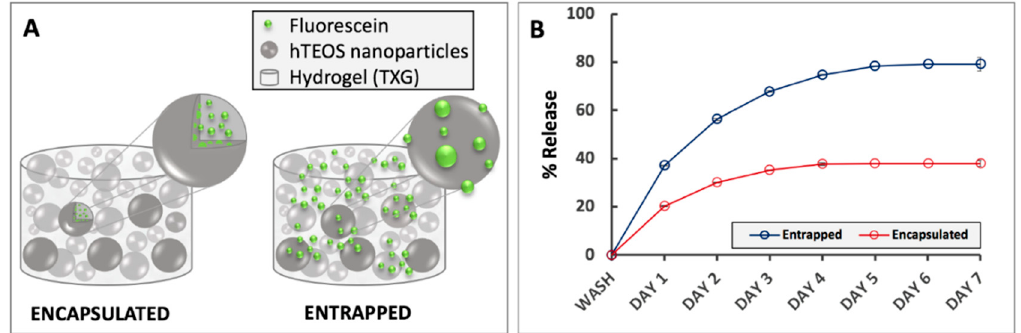
Figure 6. Effects of drug loading strategy on release rates fron TXGs. Error bars are hidden in the plot symbols when not visible. ( A )—illustration of the drug loading mechanisms into thixogels; ( B )—release profiles of the encapsulated and encased fluorescein (model drug).